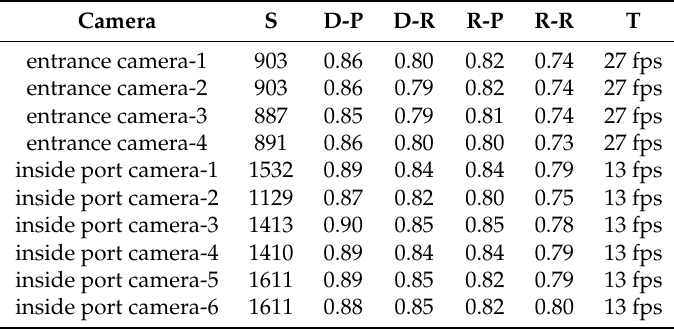
Table 8. Performance of